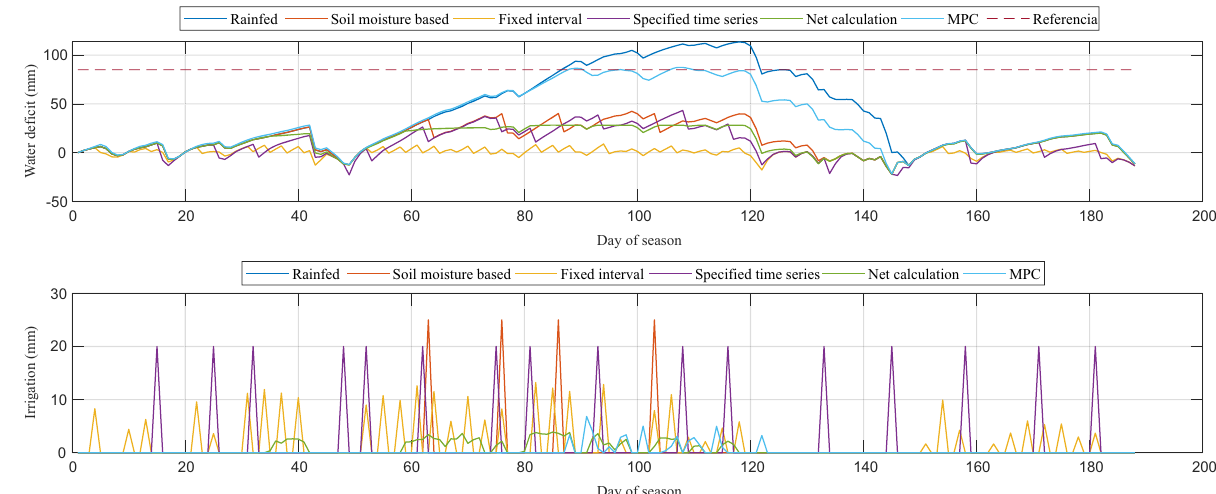
Figure 8: Comparison of the results of the irrigation methods for the Year